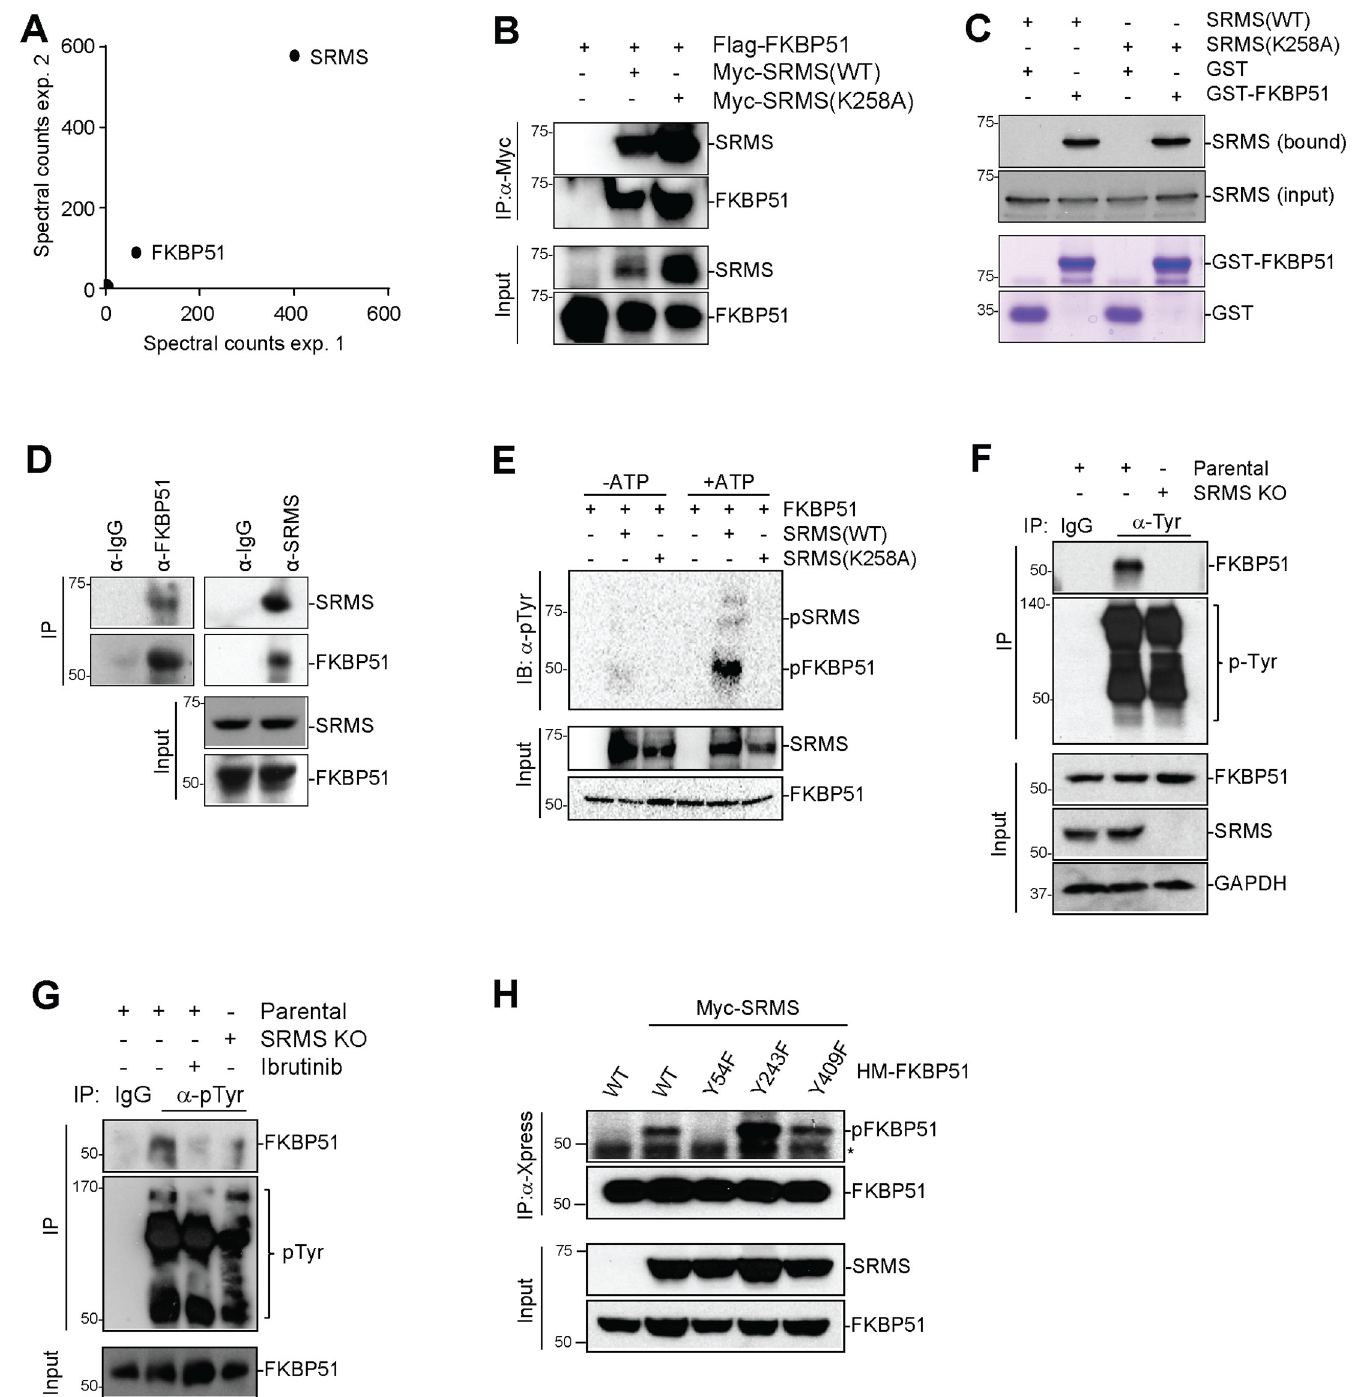
Fig 3. SRMS binds FKBP51 and phosphorylates tyrosine 54. ( A ) Substrate-trapping IP and proteomics were performed to identify candidate SRMS substrates. ( B ) WT and kinase-dead SRMS interact with FKBP51 in cells. Flag-FKBP51 was transfected with Myc-SRMS or Myc-SRMS K258A in HeLa cells. Cell lysates were subjected to IP by anti-Myc antibody and blotted with indicated proteins. Results shown are representative of 3 independent experiments. ( C ) SRMS directly interacts with FKBP51 in vitro. GST pull-down assay was performed with recombinant GST-FKBP51 and in vitro transcribed/translated Myc-SRMS (WT or kinase-dead, as indicated). ( D ) SRMS endogenously interacts with FKBP51. MDA-MB-231 cell lysates were subjected to IP with anti-SRMS or anti-FKBP51 and blotted with indicated antibodies. Results shown are representative of 3 independent experiments. ( E ) In vitro kinase assays were performed using purified recombinant GST-FKBP51 and in vitro transcribed/translated Myc-SRMS(WT) or Myc-SRMS(K258A) proteins in the presence or absence of ATP. Tyrosine phosphorylation of FKBP51 was probed via